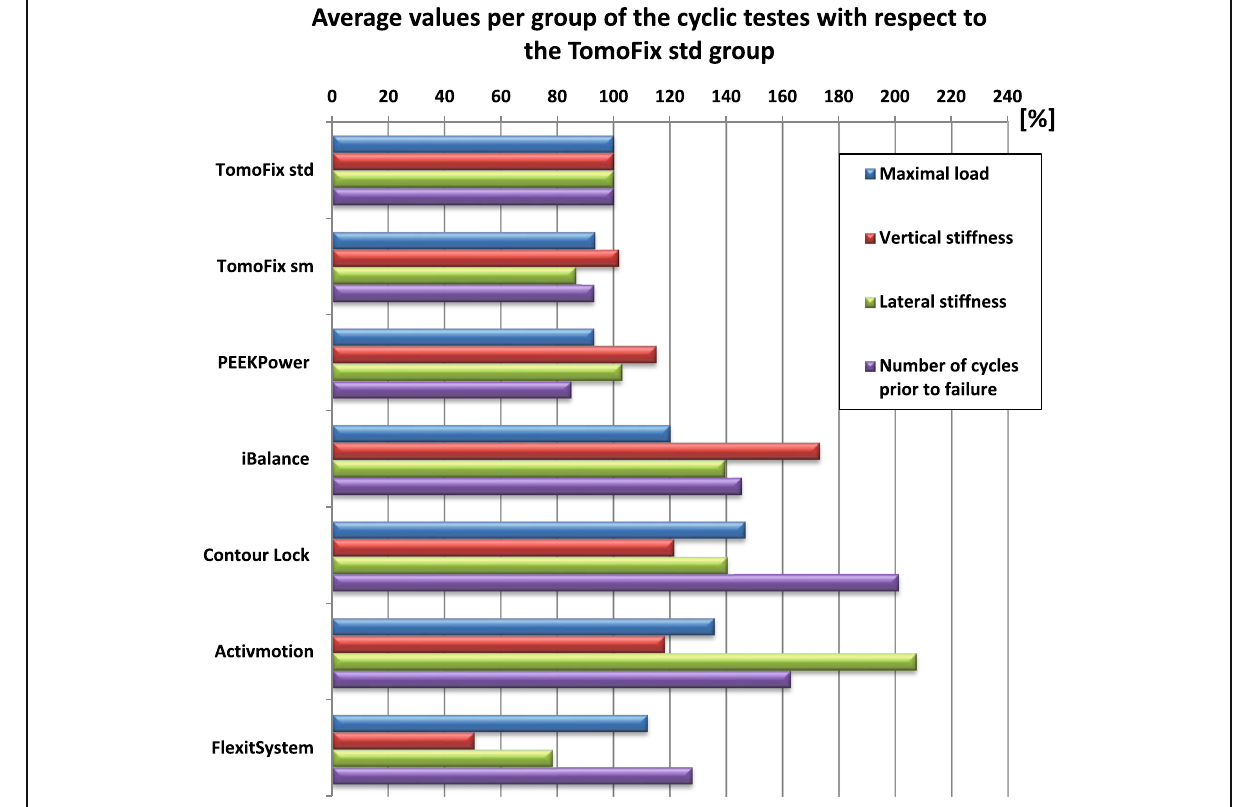
Fig. 8 Average relative strength values of Table 6. The TomoFix std. group has been taken for